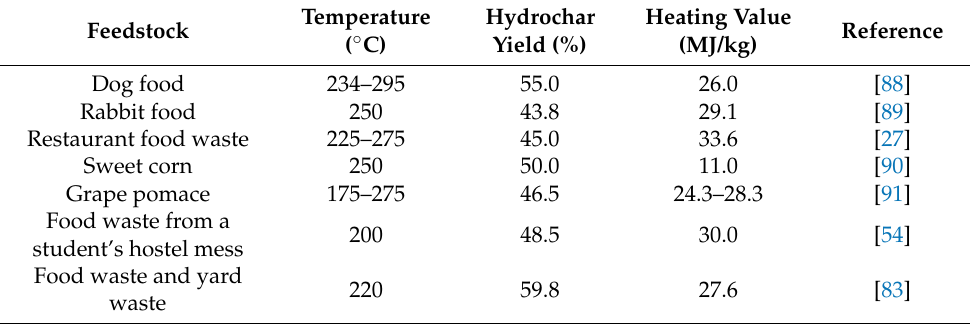
Table 3. Hydrochar yield of food waste and its calorific